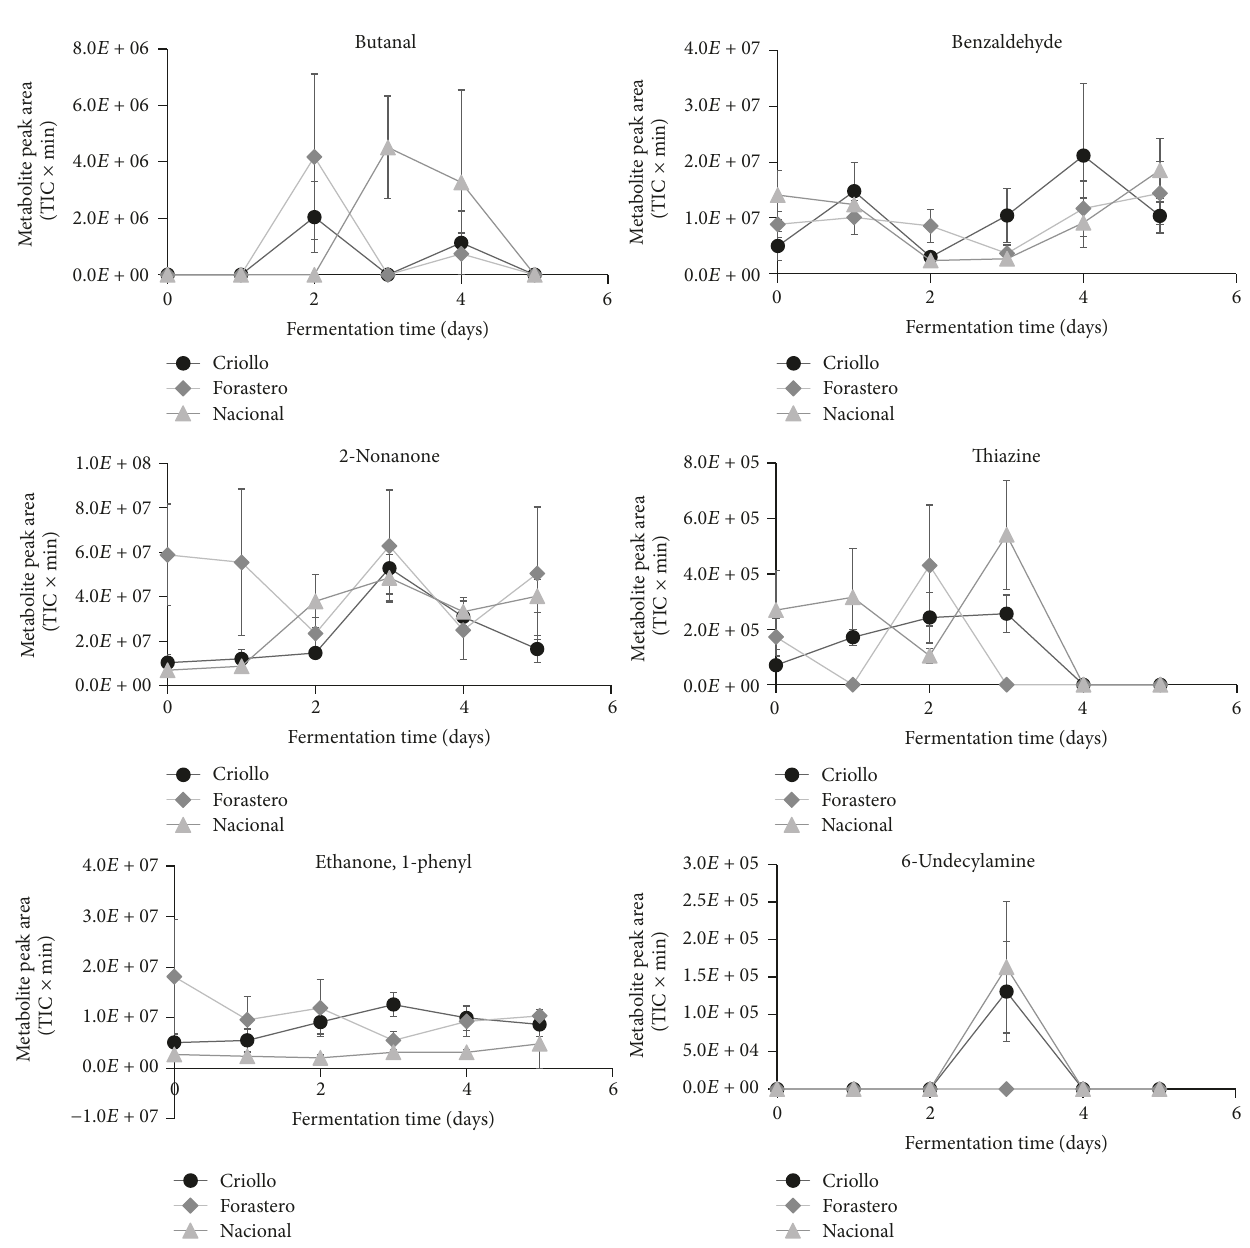
Figure 7: Levels of significant volatiles classified as others in Criollo, Nacional, and Forastero beans at different fermentation times. Levels of each metabolite are presented as peak area (total ion current times the differential retention time for each metabolite in